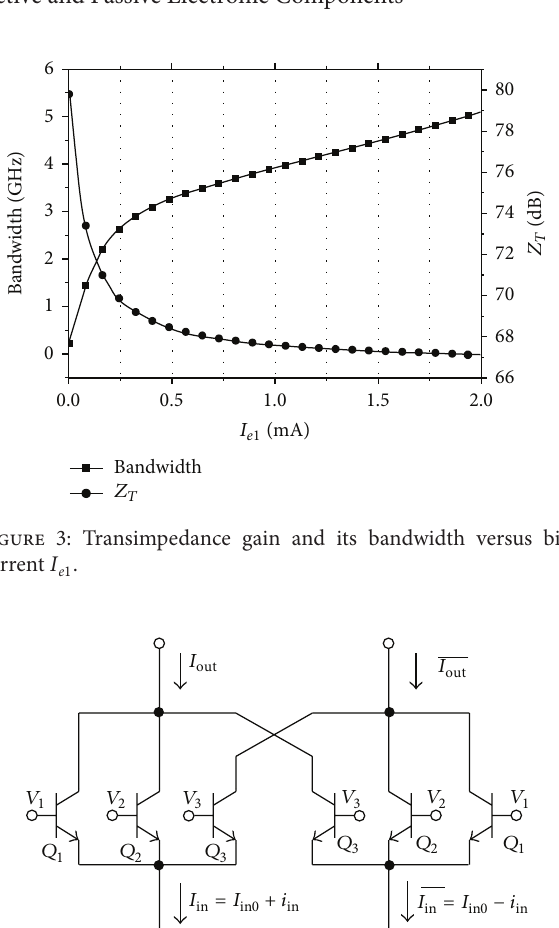
Figure 4: Generalized hybrid current-steering current gain cell.